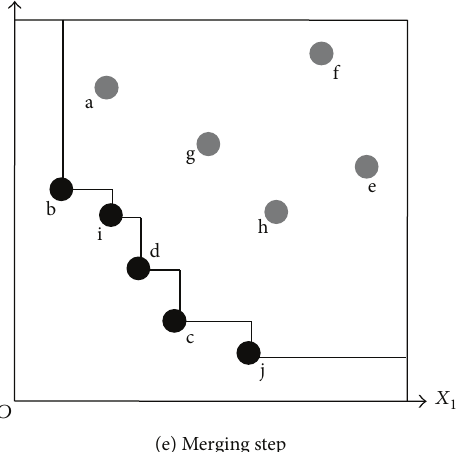
Figure 2: The overall procedure for processing Grid-PPPS in the two-dimensional data